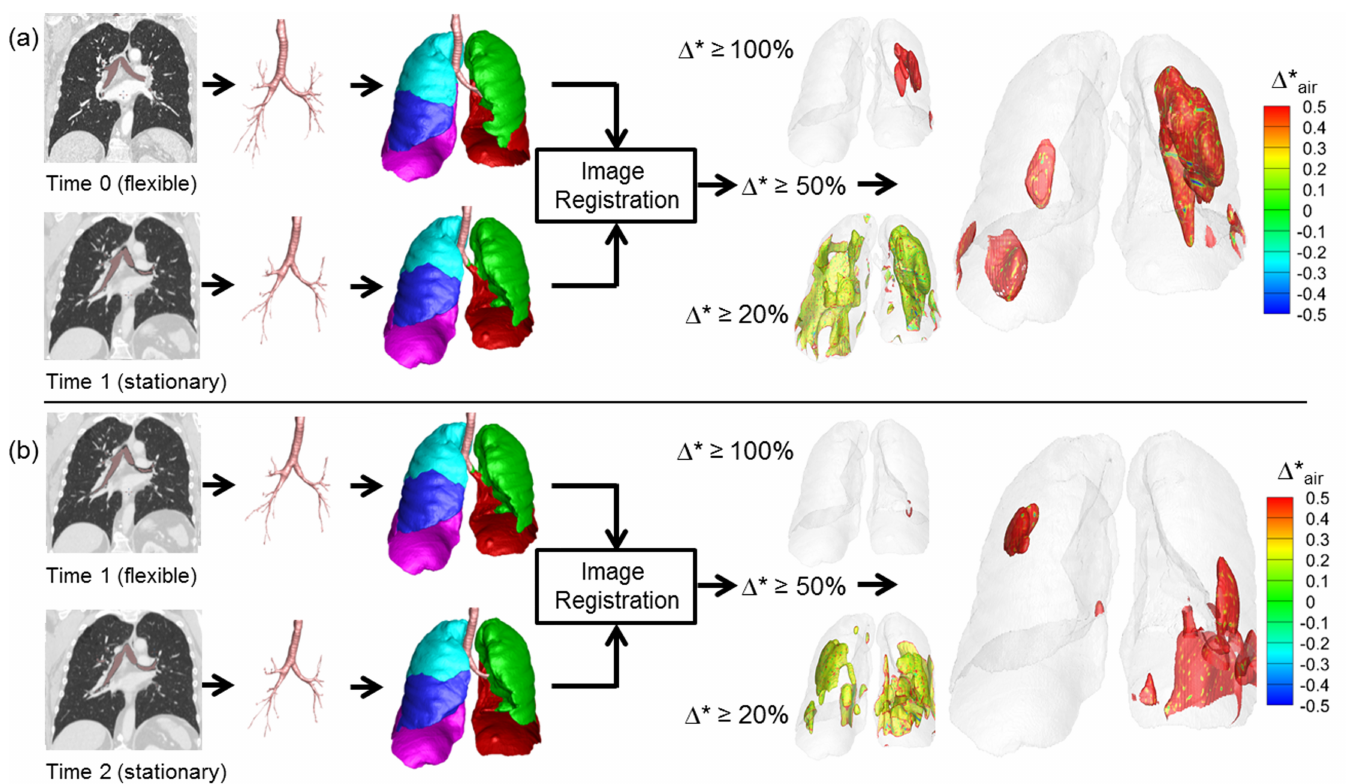
Fig 6. Regional hyper-expansion signals in serial CT pairs of a sarcomapatient (Group 3) with no lung metastasisbut with therapy and resection. (a) Time 0 to Time 1 and (b) Time 1 to Time 2. Lung metastases were not found at any of the three time points, Time 0, Time 1 and Time 2.